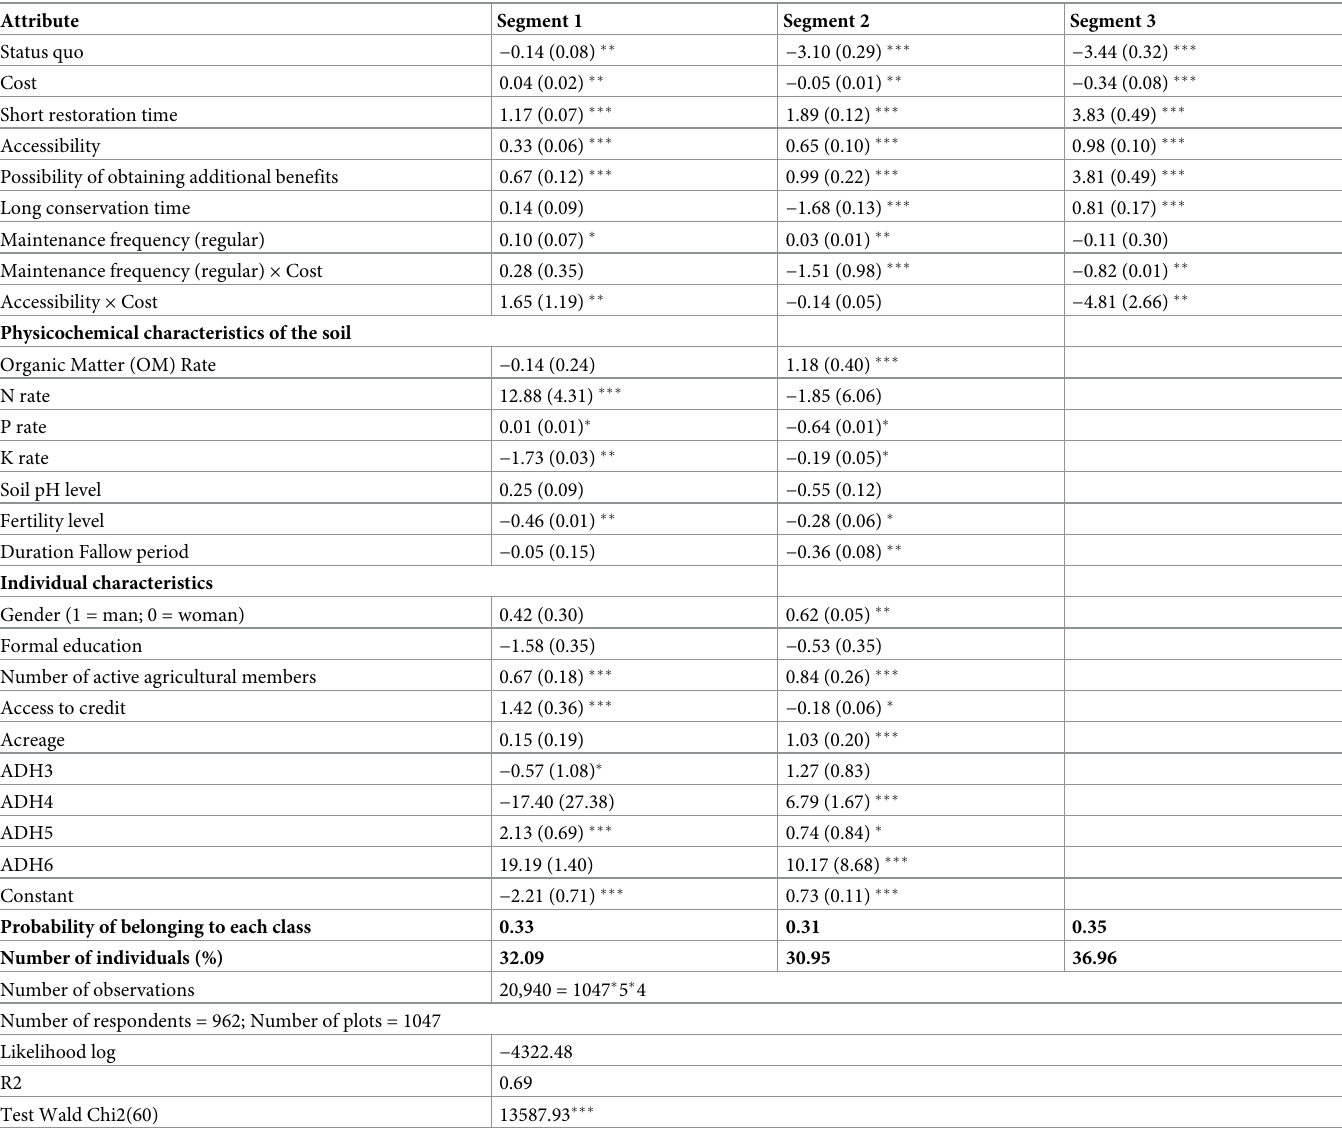
Table 6. Estimation of the model 3 latent